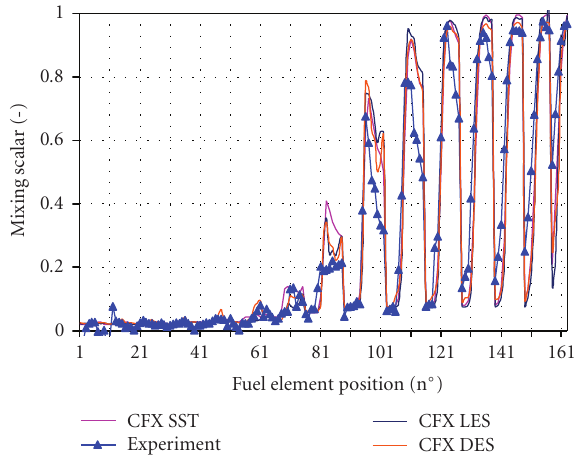
Figure 12: Relative temperature rise at the core inlet calculated with the three di ff erent turbulence models in comparison with the experimental values.